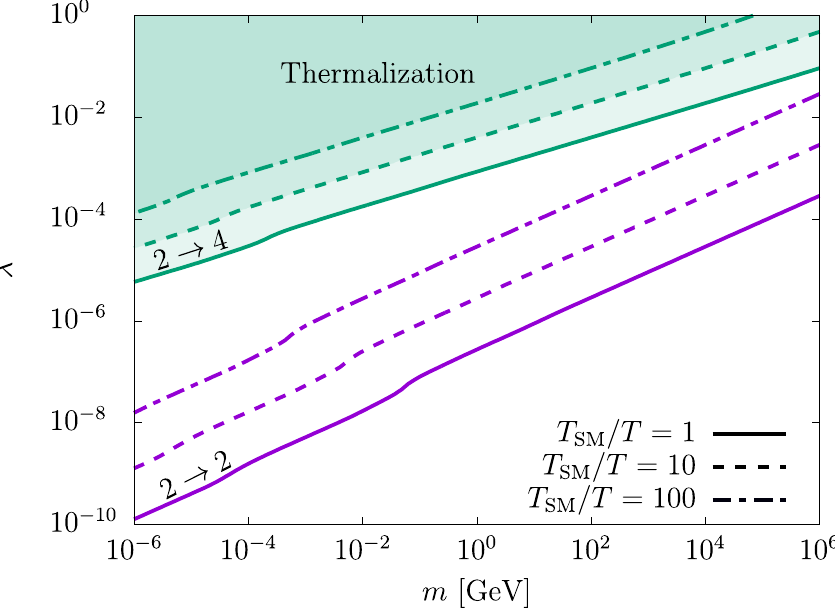
Figure 2 . Parameter space consistent with thermal or kinetic equilibrium for different ξ = T SM /T . Couplings above the green (purple) lines are necessary for thermal (kinetic) equilibrium neglecting the chemical